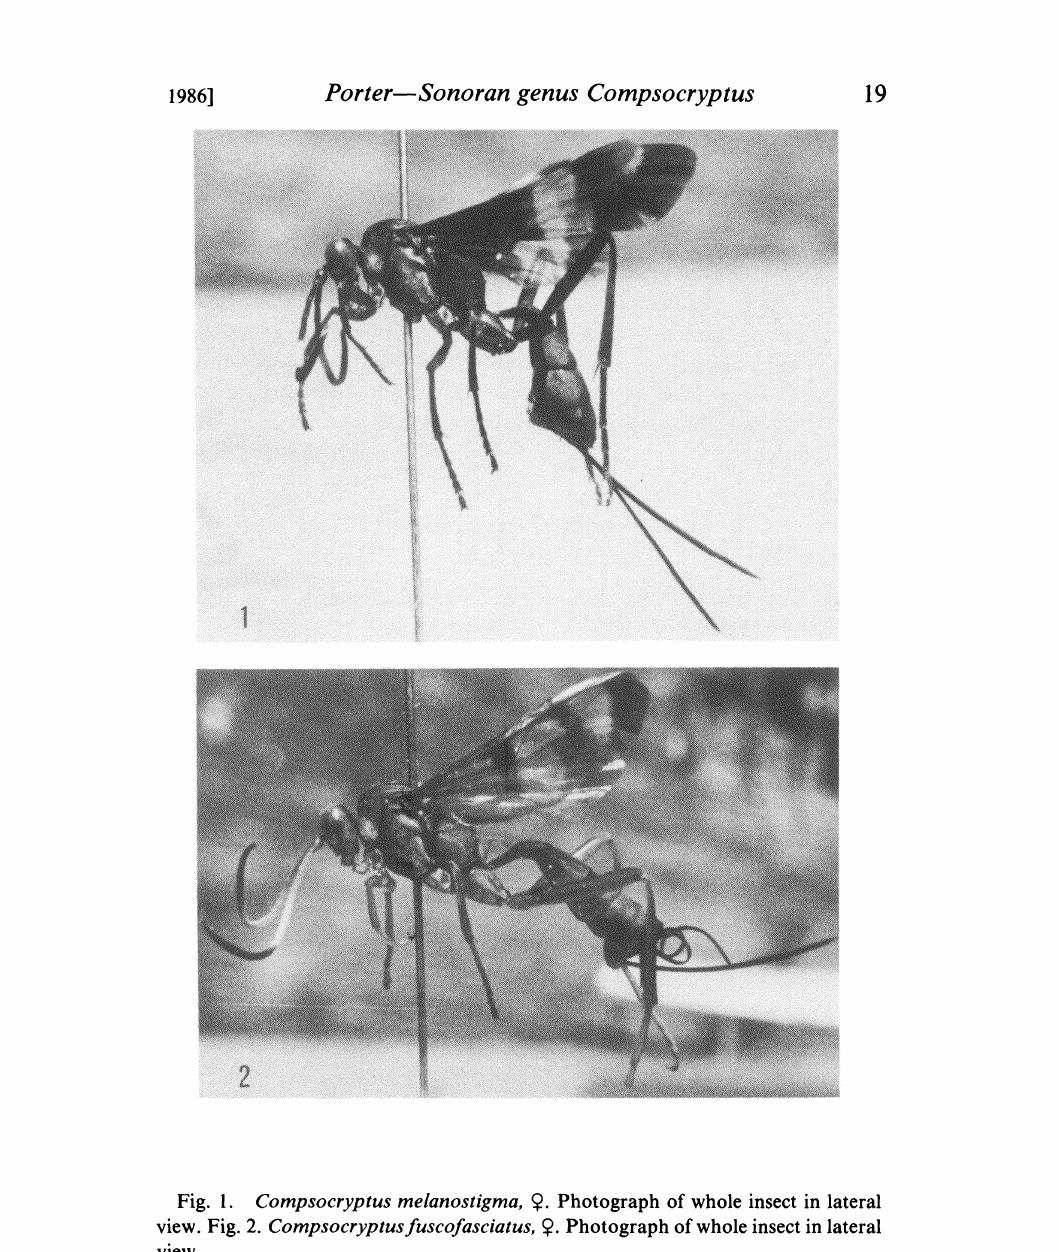
Fig. 1. Compsocryptus melanostigma, view. Fig. 2. Compsocryptusfuscofasciatus,